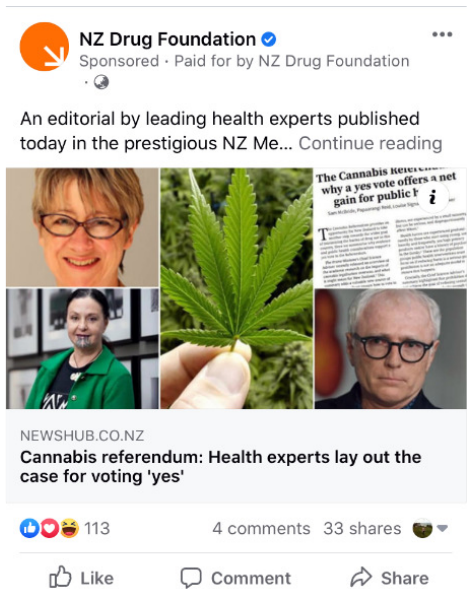
Figure 3. Example of anti‐legalisation campaigner adver‐ tisement on